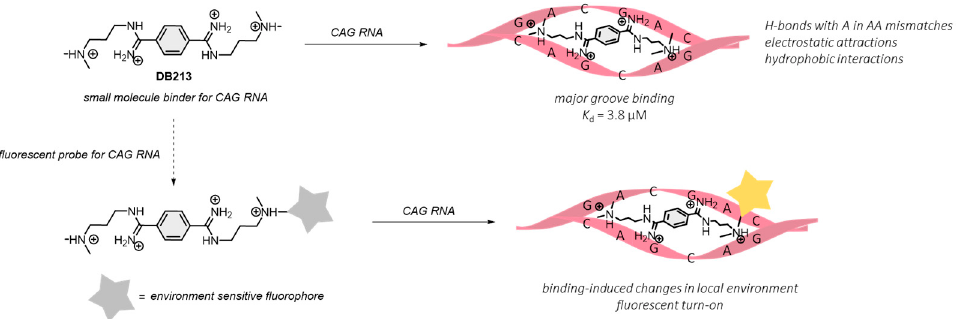
Figure 1. Chemical structure of DB213 that binds selectively to CAG RNA, and the design of a fluorescent probe for CAG RNA.